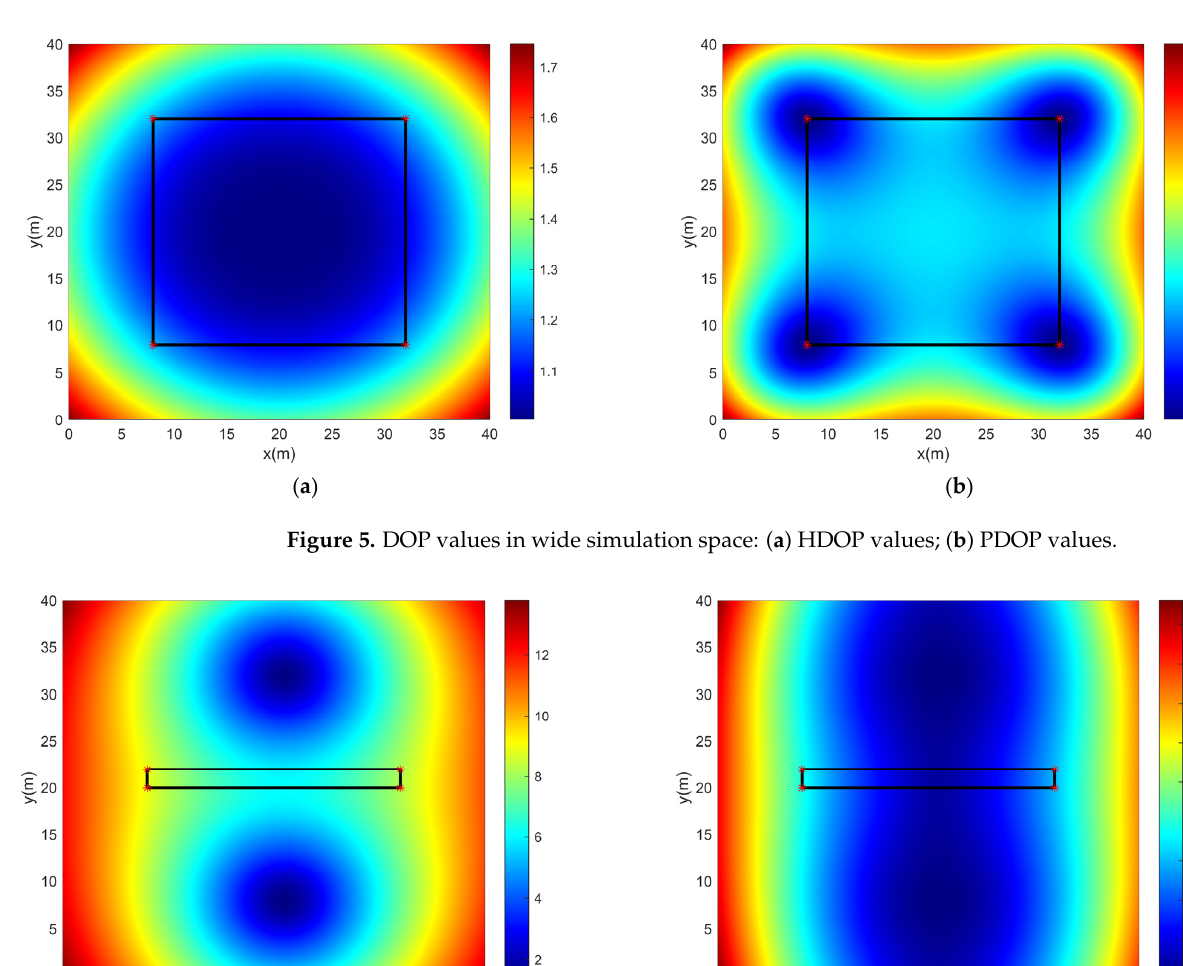
3 Table 2. Base station coordinates in a corridor simulation space. A0 3 Table 3. Base station coordinates in a passage simulation space.